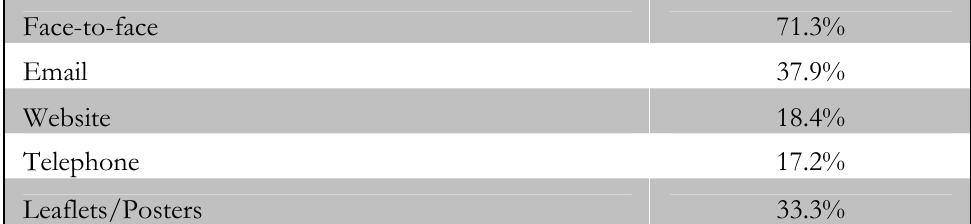
Table 7. Mobilized through the workplace or the university